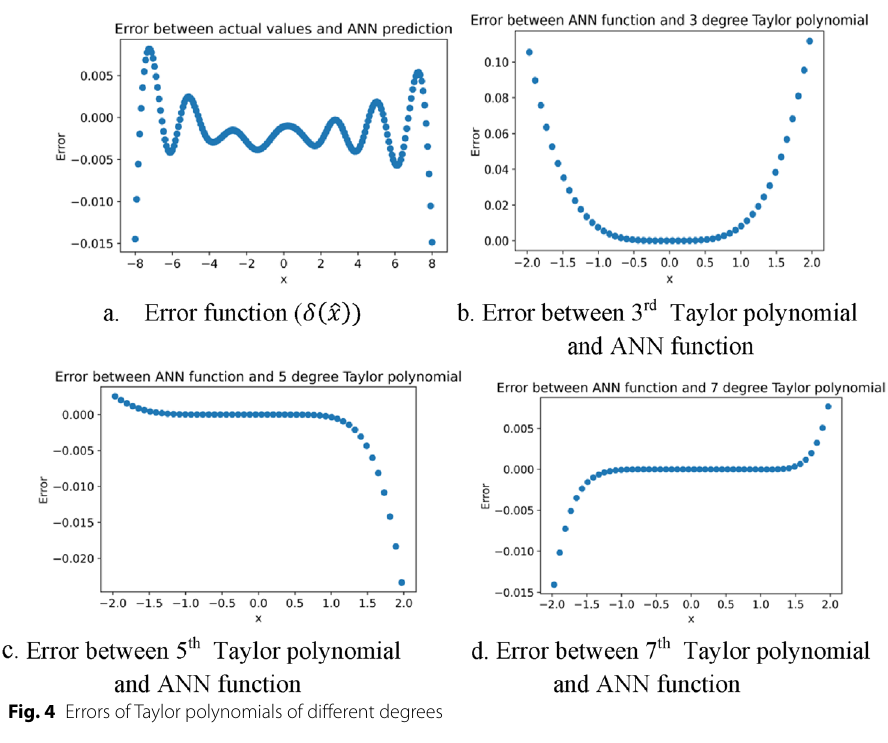
Fig. 4 Errors of Taylor polynomials of different degrees